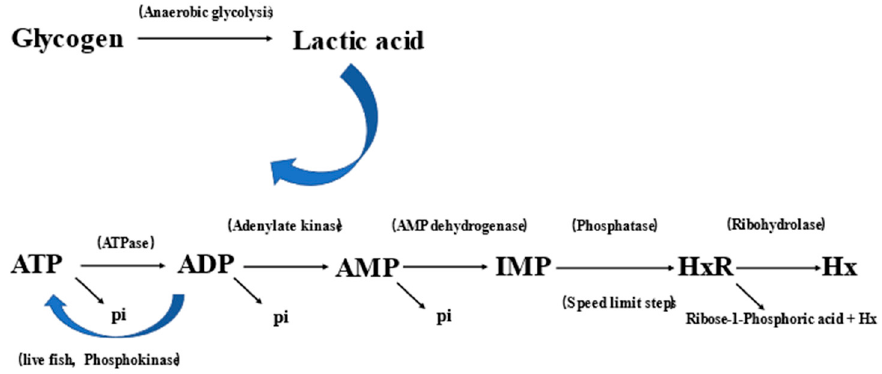
Figure 5. Degradation pathway of ATP in fish flesh.